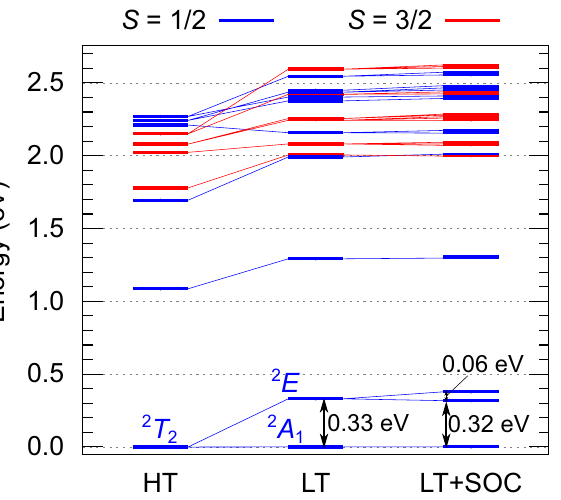
Figure 3. Influence of Jahn–Teller distortion on the low-energy excitation spectrum of GaMo 4 S 8 . Both high-temperature (HT) and low-temperature (LT) energies are given for the [Mo 4 S 16 ] 19- cluster model (NEVPT2(11e,12o)), including SOC for the latter. Six quartets and ten doublets were included in the state- averaging